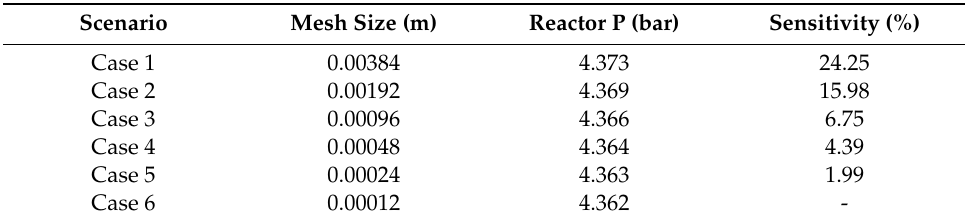
Table 3. Sensitivity scenarios.